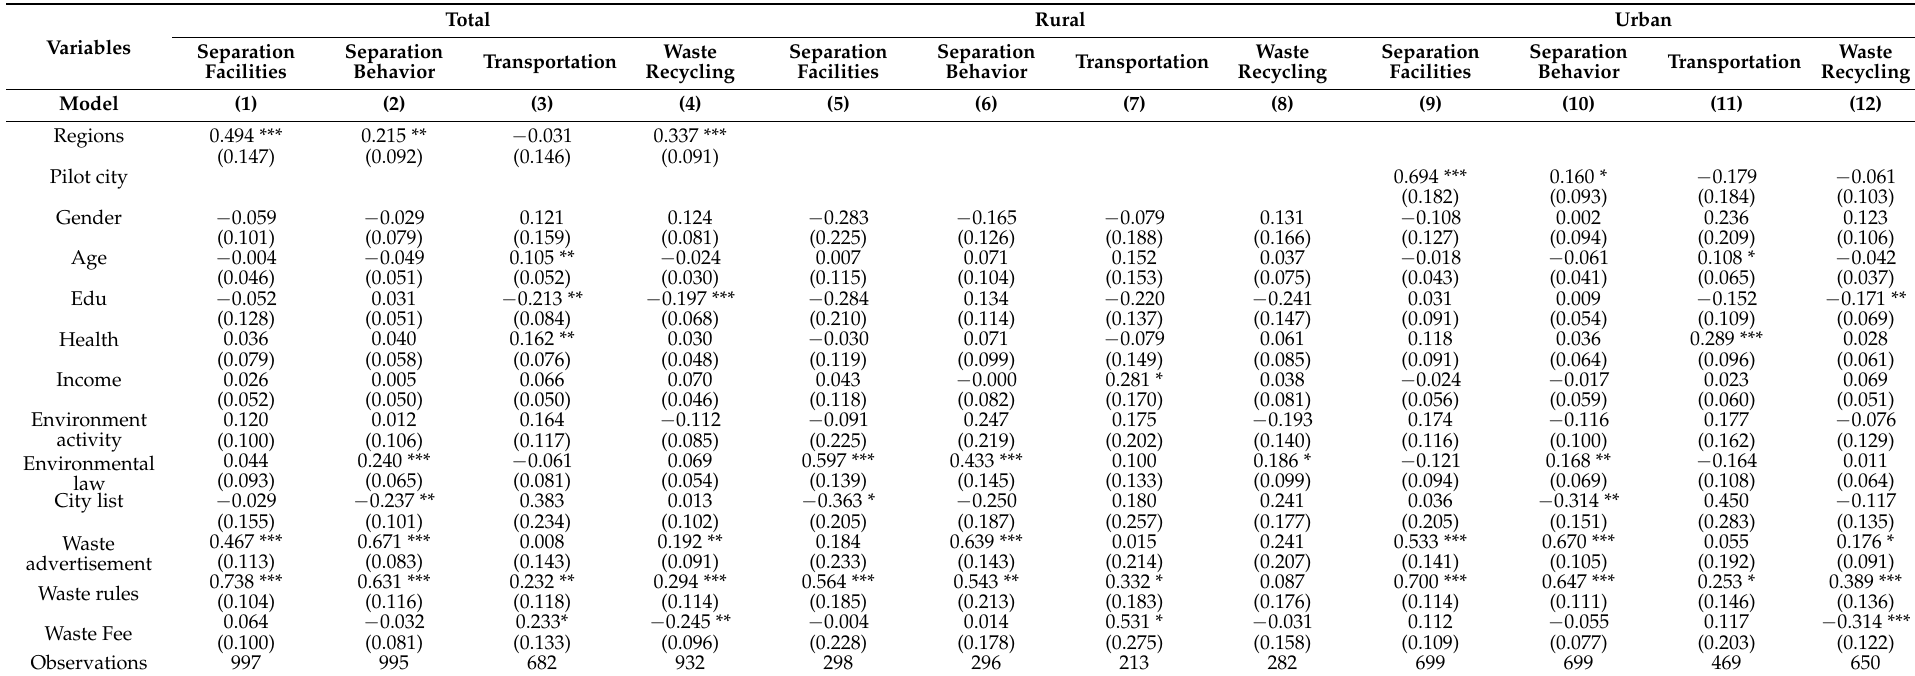
Table A2. The relationship between socioeconomics and environmental knowledge and community institution variables and